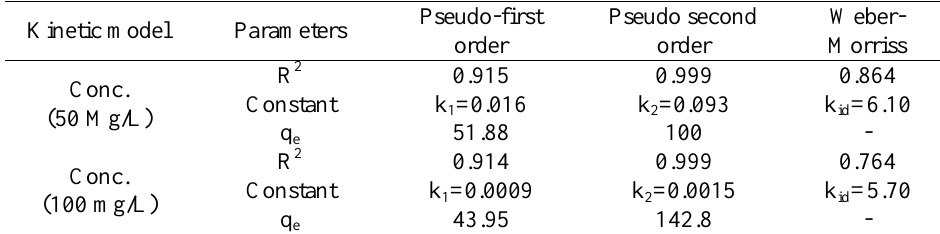
Table 4. Kinetic details of AR18 adsorption by